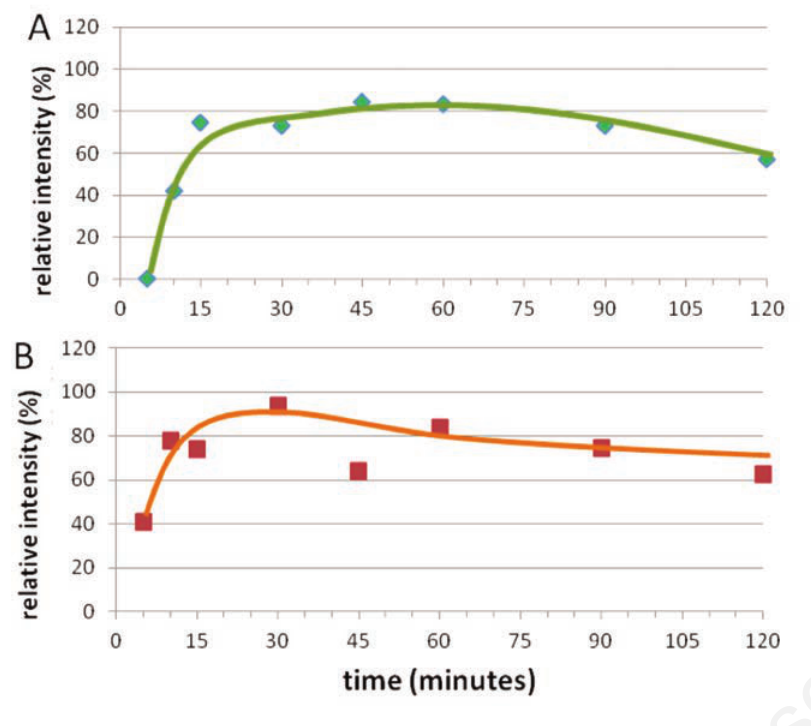
Figure 2. Relative intensity of indigotine color (E132) in crab haemolymph. A) Lateral injection (t=0) and contra-lateral sampling through the right and the left fourth paraeo- pod, respectively. B) Dorsal injection through the injection device (t=0) and lateral sam- pling at the left fourth paraeopod.